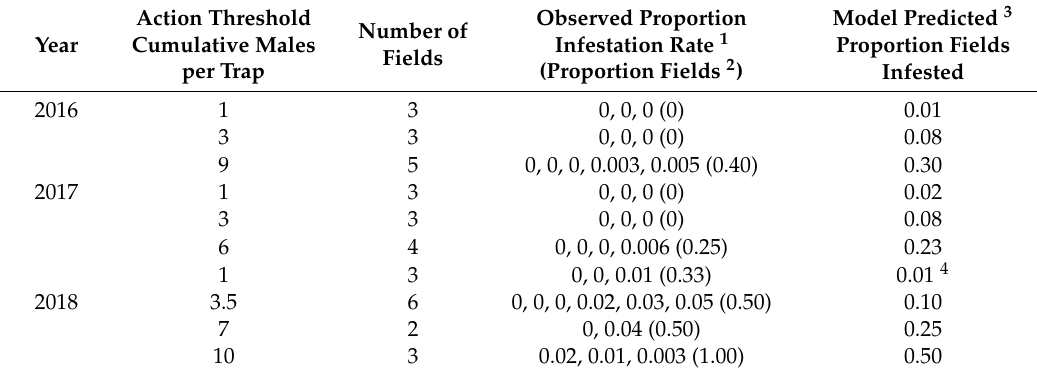
Table 6. Validation of action thresholds in commercial wild blueberry fields